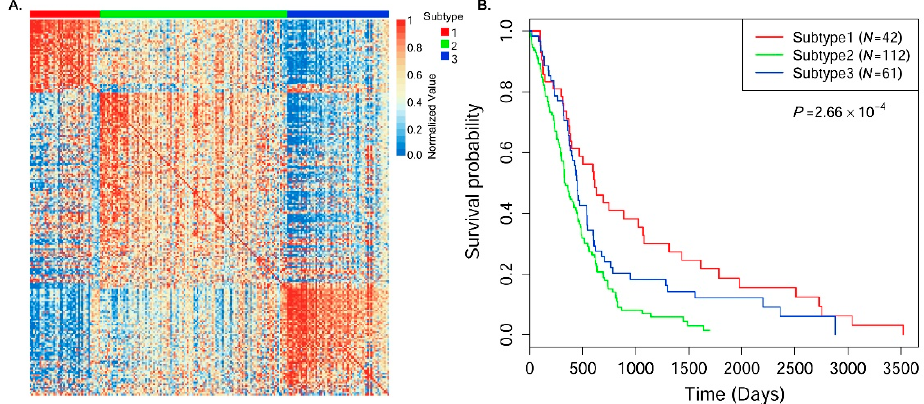
Figure 4. The identified subtypes in GBM cancer datasets. ( A ) Heatmap of the predicted integrative similarity matrix between samples (row normalized, arranging samples by predicted subtype labels); ( B ) Kaplan–Meier survival probability curves of patients in the identified subtype clusters. The Cox log-rank test p -value was included.